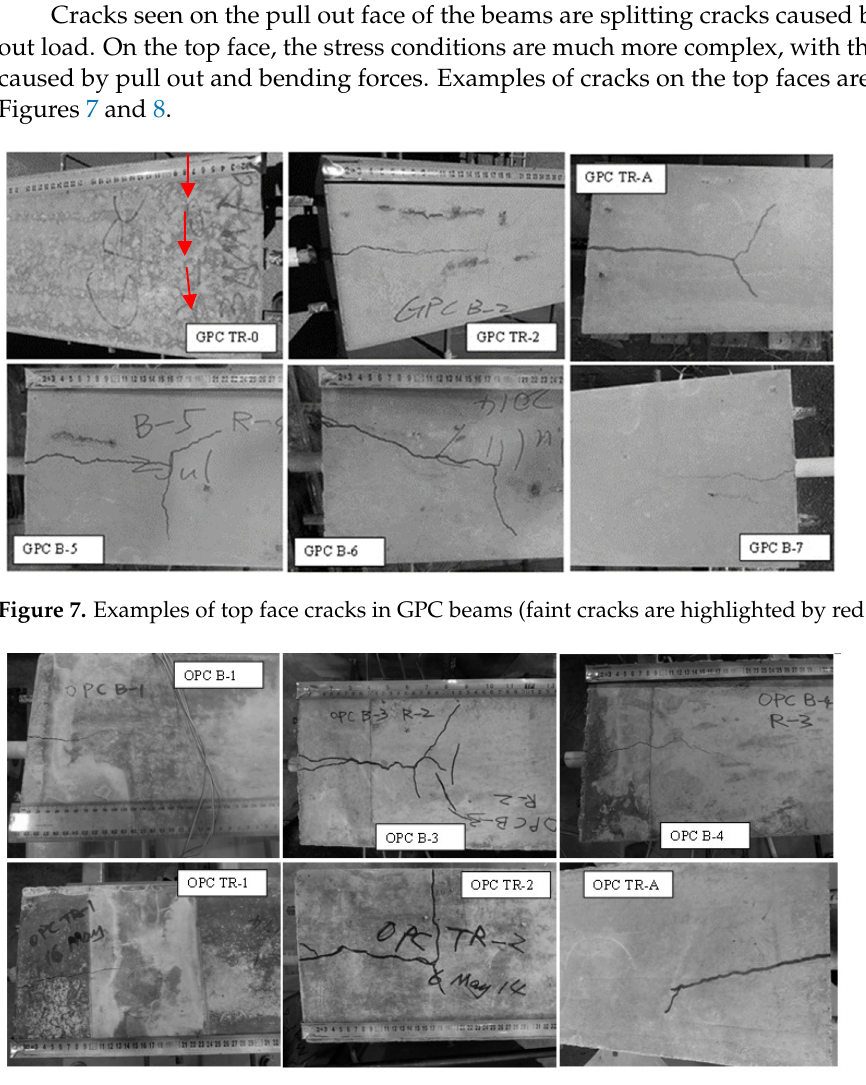
Figure 8. Examples of top face cracks on OPC beams.